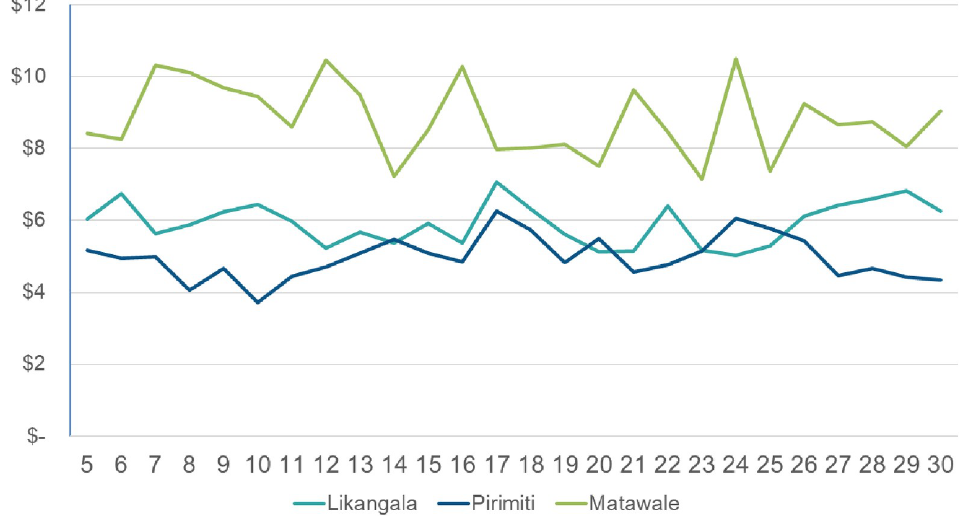
Fig 3. Median weekly cash outflows by site.